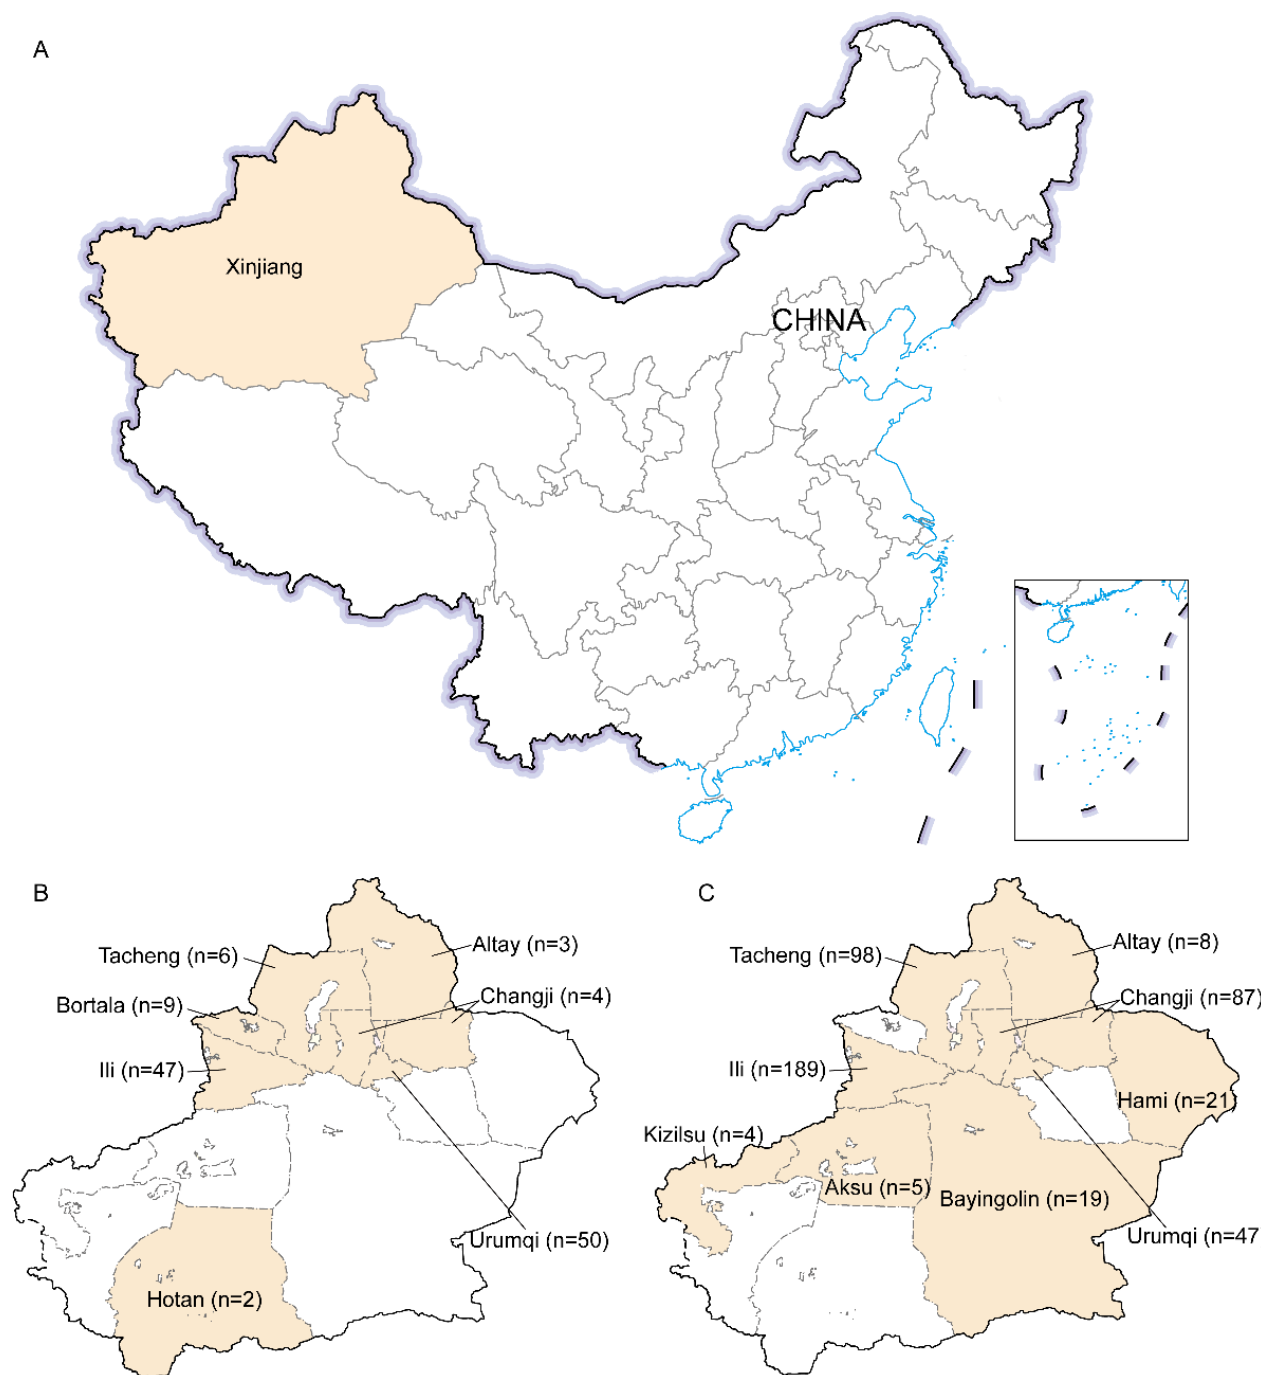
Figure 1. A simplified map of Xinjiang (Northwest China), where Hepatitis E virus strains were collected. The geographical locations of the strains detected in the study are marked in yellow. ( A ) the location of Xinjiang in China. ( B ) The prefectures where samples were collected from feral wild boars. ( C ) The prefectures where samples were collected from farmed wild boars.